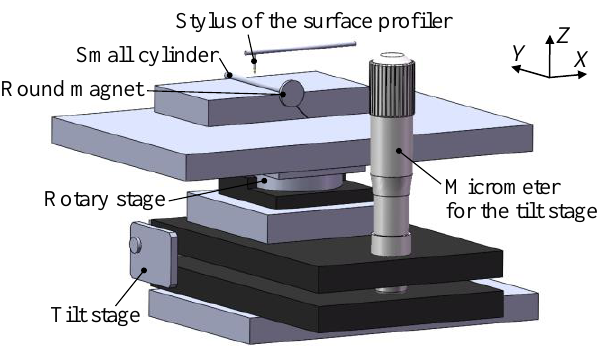
Figure 6. Schematic of the setup employed in experiments.